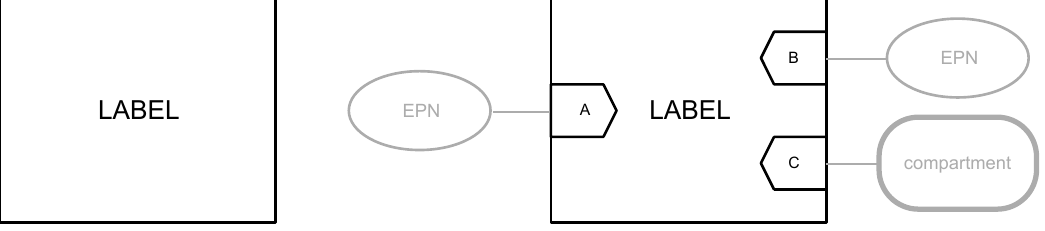
Figure 2.59: The Process Description glyph for submap , shown plain and unadorned on the left, and with three submap terminals on the right.